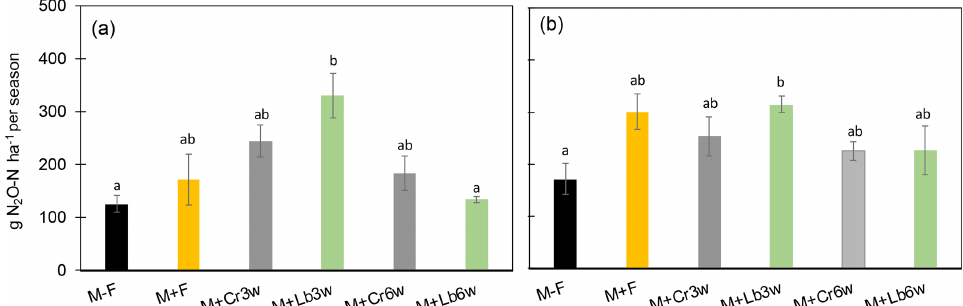
Figure 2. Cumulative seasonal N 2 O-N(gNha − 1 per season) in 2015 (a) and 2016 (b) throughout 107 and 123d, respectively, in treatments with and without legume intercropping. Error bars denote SEM ( n = 4). Different letters indicate significant differences at p < 0 . 05. M + F: fertilized maize; M + Cr3w: fertilized maize with Crotalaria sown 3 weeks after maize; M + Cr6w: fertilized maize with Crotalaria sown 6 weeks after maize; M + Lb3w: fertilized maize with lablab sown 3 weeks after maize; M + Lb6w: fertilized maize with lablab sown 6 weeks after